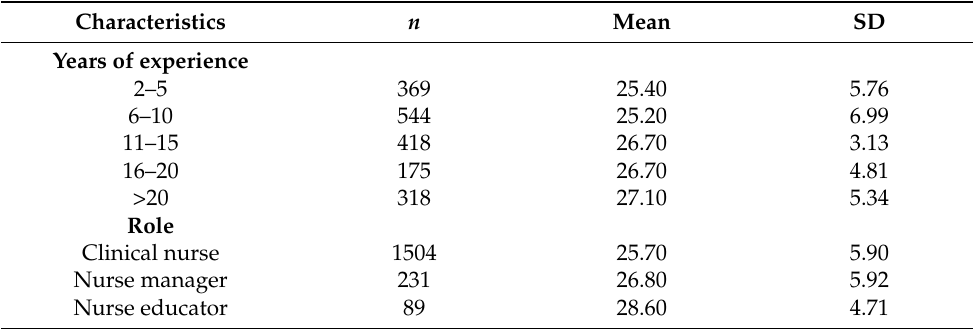
Table 5. Mean total facilitator score for nurses’ experience levels and clinical roles.